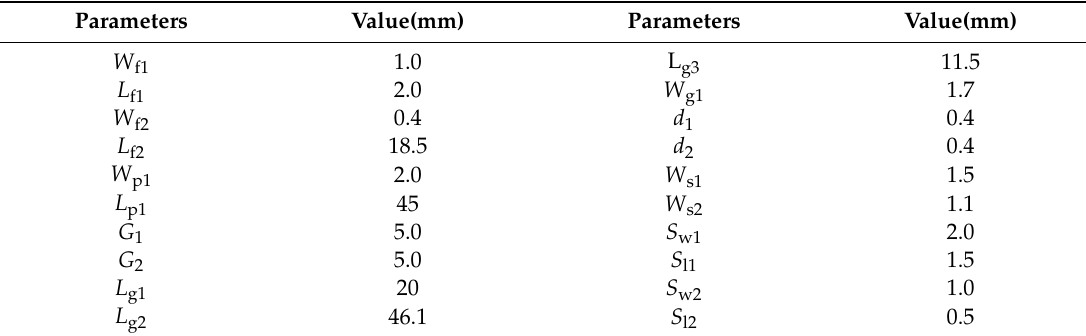
Table 1. Design parameters of the proposed antenna.